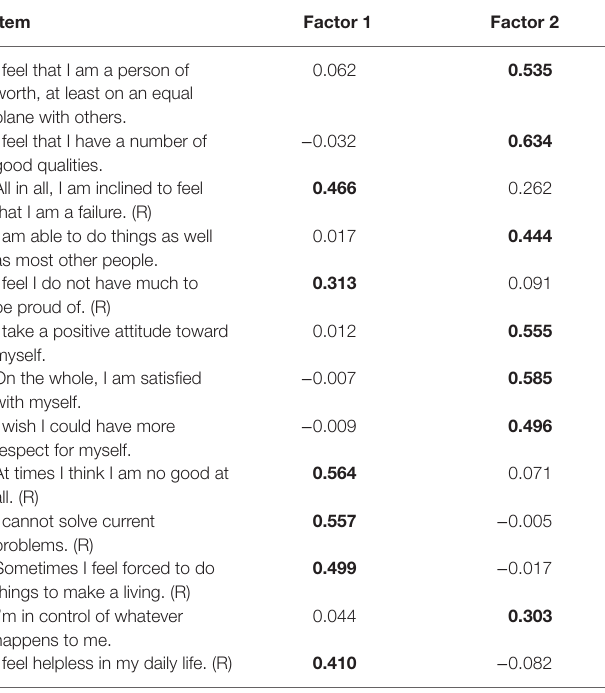
TABLE 5 | Modeling the associations between parents’ childbearing motivation and children’s academic performance and well-being (standardized structure equation estimates) in Study 2.